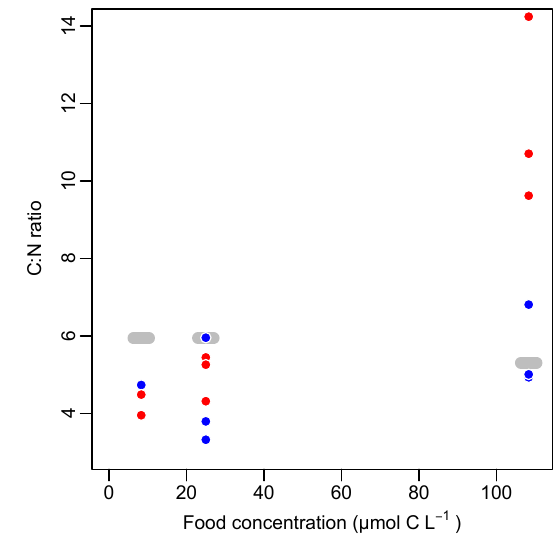
Figure 4. Resource stoichiometry in the experiment, presented as the C:N ratio of the resource vs. the C:N ratio in the coral tissue after the incubation. The grey bar is the C:N ratio of the suspended food (i.e. algae + bacteria), the blue dots are the C:N ratios of the coral tissue in the treatment 13 C-algae + 15 N-bacteria and the red dots are the C:N ratios of the coral tissue in the treatment 15 N- algae + 13